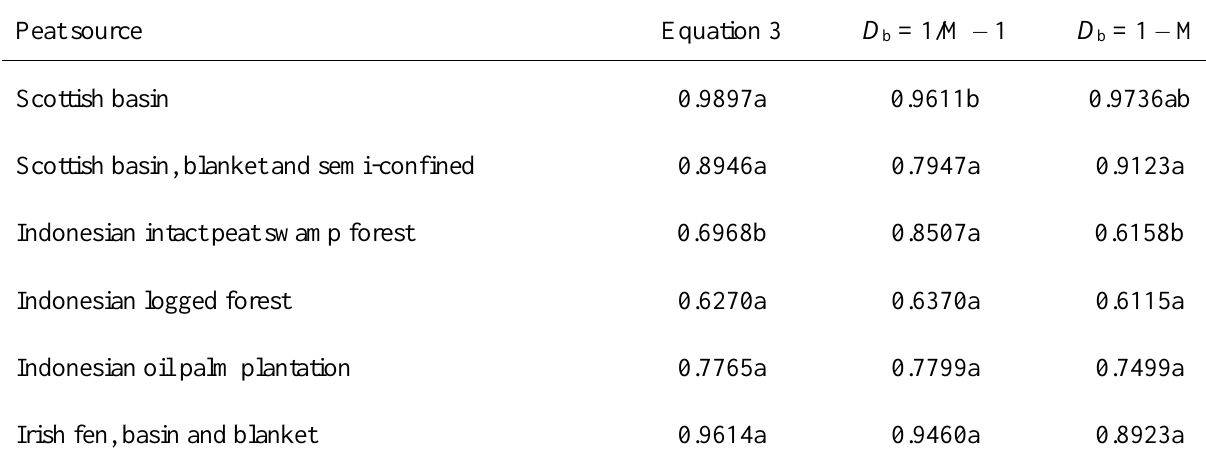
Table A1. Lin’s concordance correlation coefficients comparing three equations for predicting dry bulk density. Values followed by a different letter are significantly different (P >